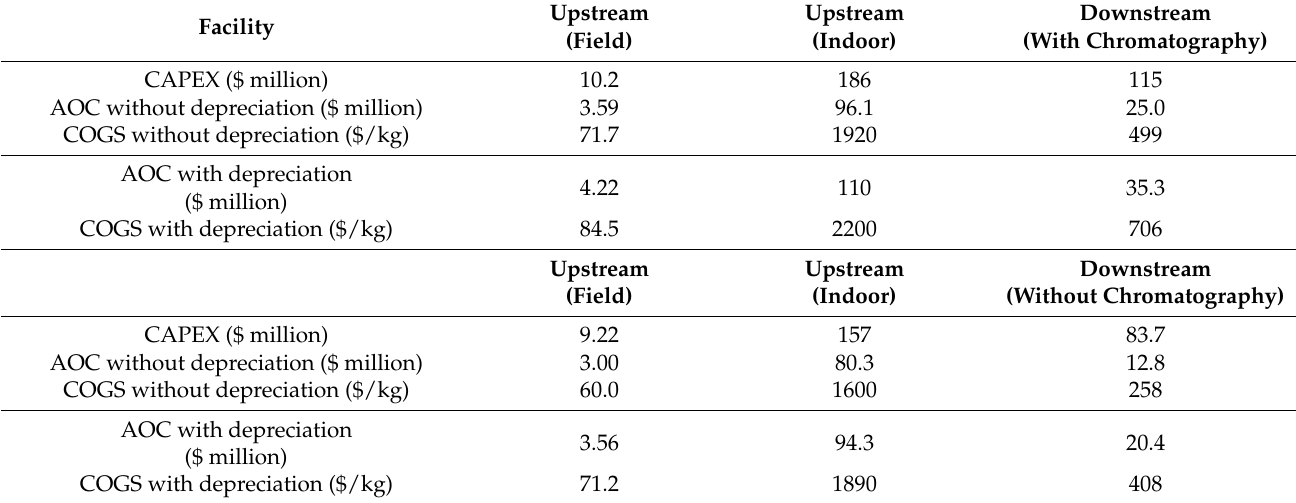
Table 1. Capital expenditure (CAPEX), annual operating costs (AOC), and cost of goods sold (COGS) for transgenic thaumatin production facilities. Depreciation is based on the 10-year straight line